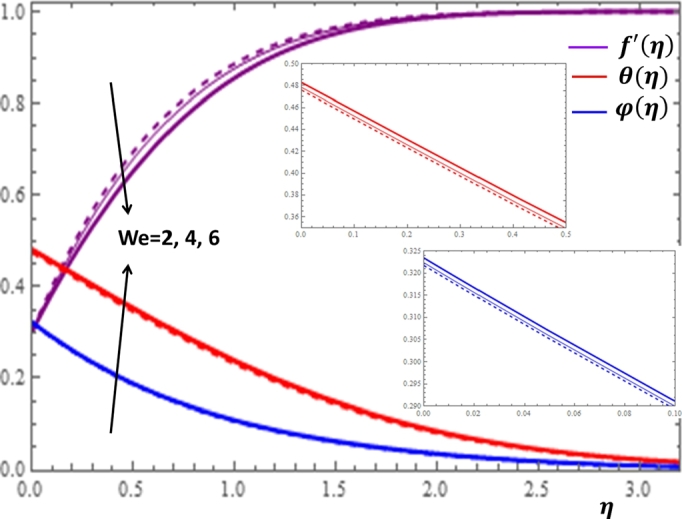
Impacts of Weissenberg number We on f′(η), θ(η) and φ(η).